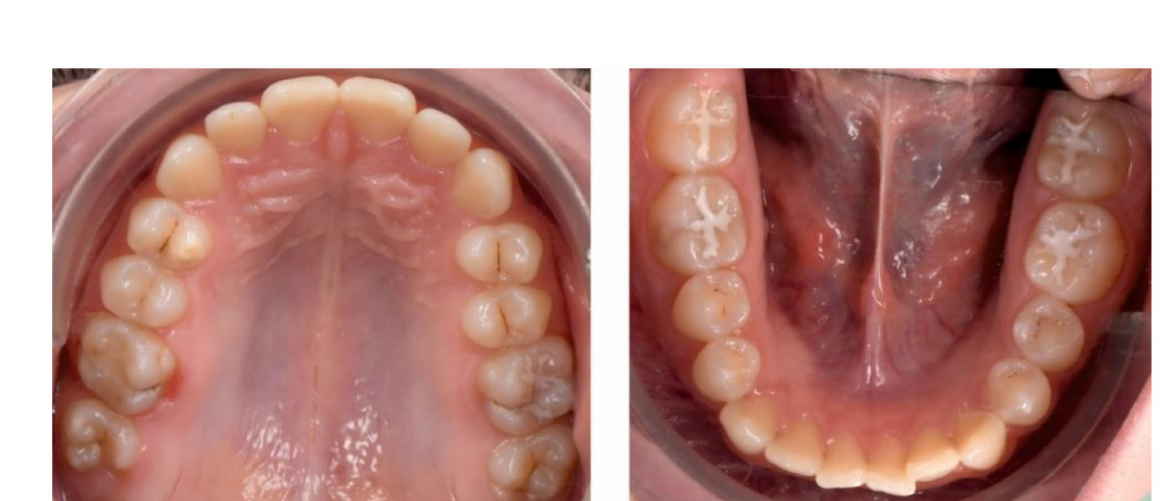
Figure 25. Intra-oral occlusal aspect at the one-year follow-up appointment. The final panoramic radiograph shows no root resorption and roots are parallel, with only few osteoclastic lesions are present, and condensation of the entire length of the mandible is visible (Figure 26).